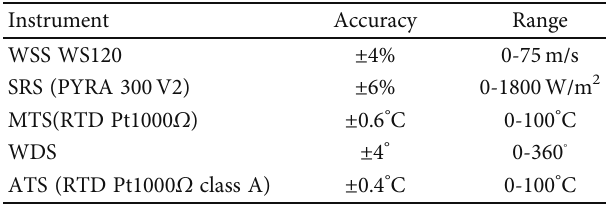
Table 2: Sensor ’ s technical speci fi cations in weather station